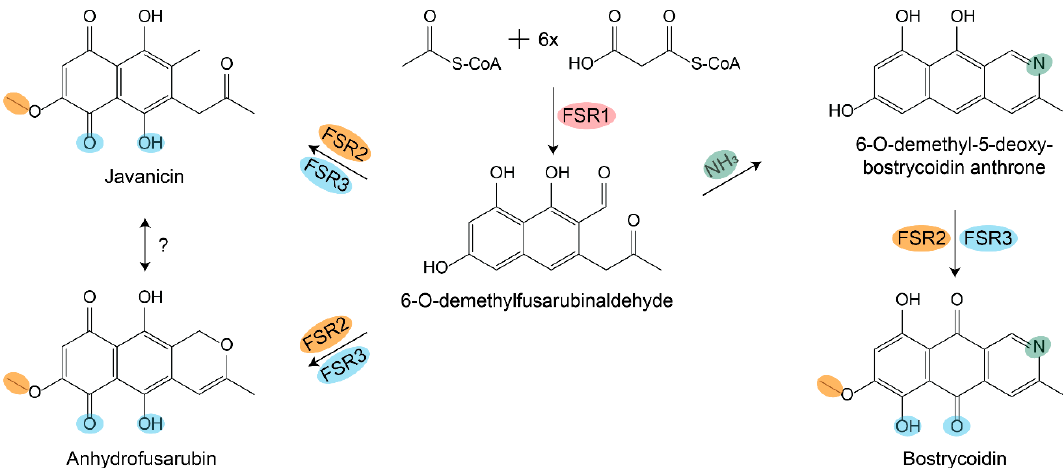
Figure 4. Suggested biosynthetic pathways leading to bostrycoidin, javanicin, and anhydrofusarubin.